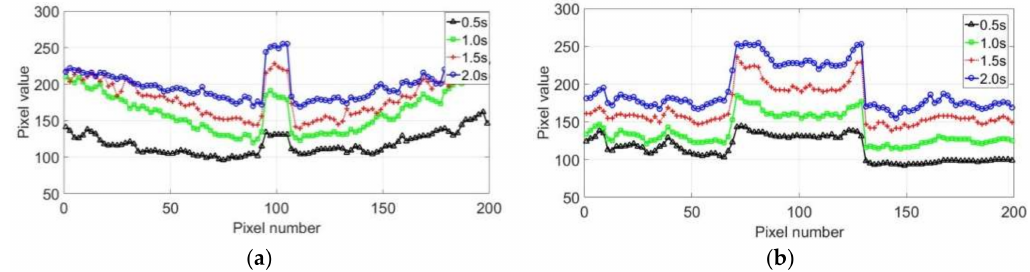
Figure 11. Temperature distribution of the line at different times: ( a ) horizontal and ( b ) vertical